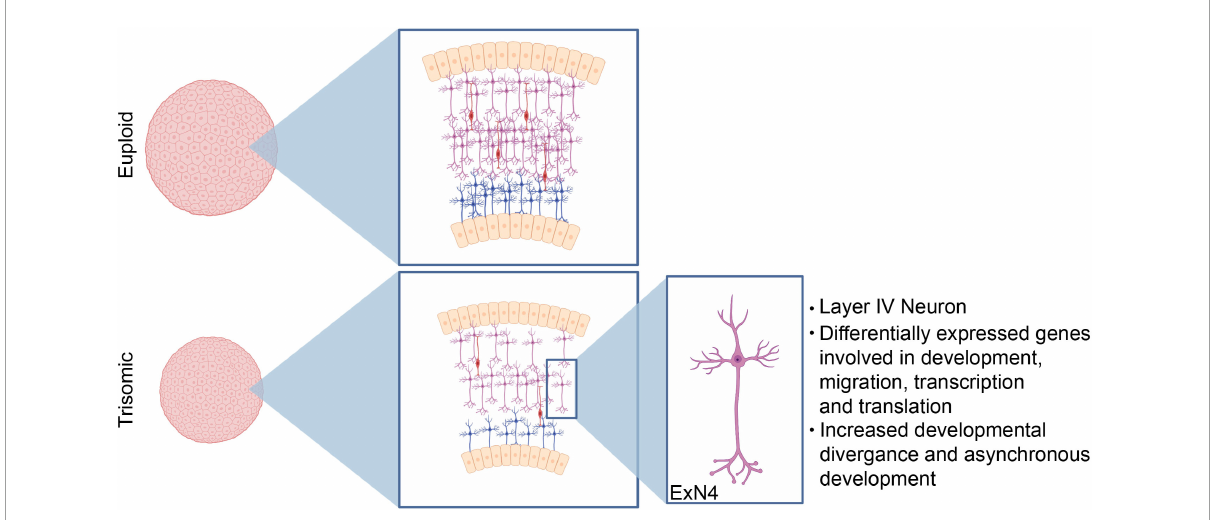
FIGURE6 Neurodevelopmental changes driving decreased trisomic spheroid size. Our data demonstrates that the consistent decrease in volume of the trisomic cortical spheroids primarily stems from perturbed neurodevelopmental processes including decreases in excitatory neuron production. Specifically, our bioinformatic analysis identifies a cluster of excitatory neurons with a transcriptional signature identifying them as layer IV cortical neurons as the most affected cell type.